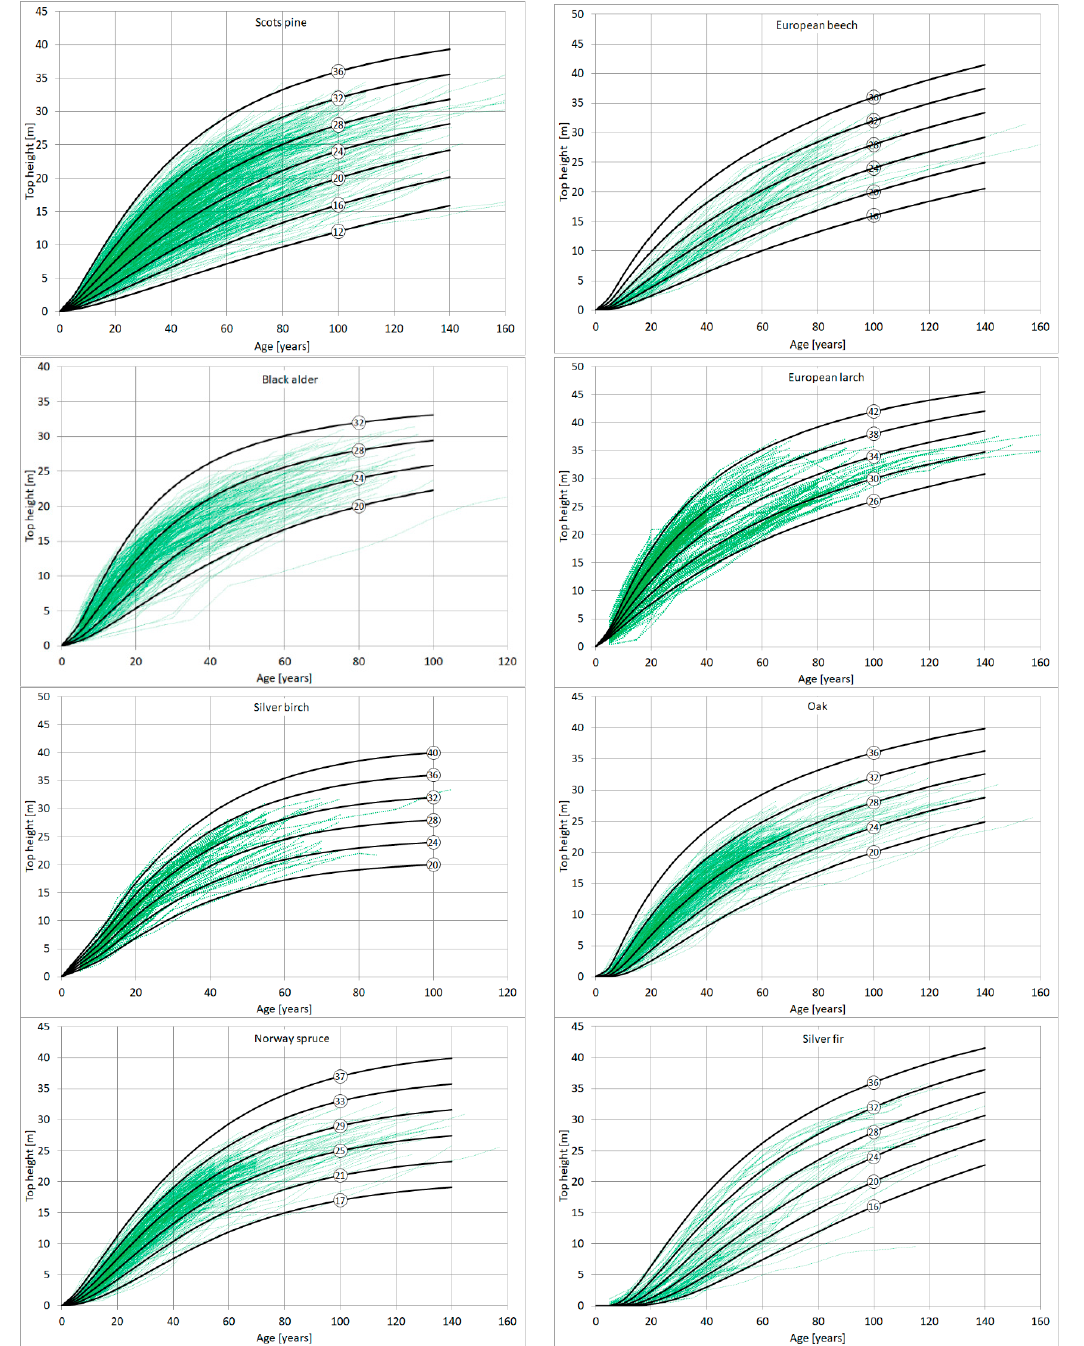
Figure 2. Site-specific height growth curves representing the developed site index models, along with the observed height growth trajectories obtained from stem analysis. The numbers in circles show the corresponding values of the site index .